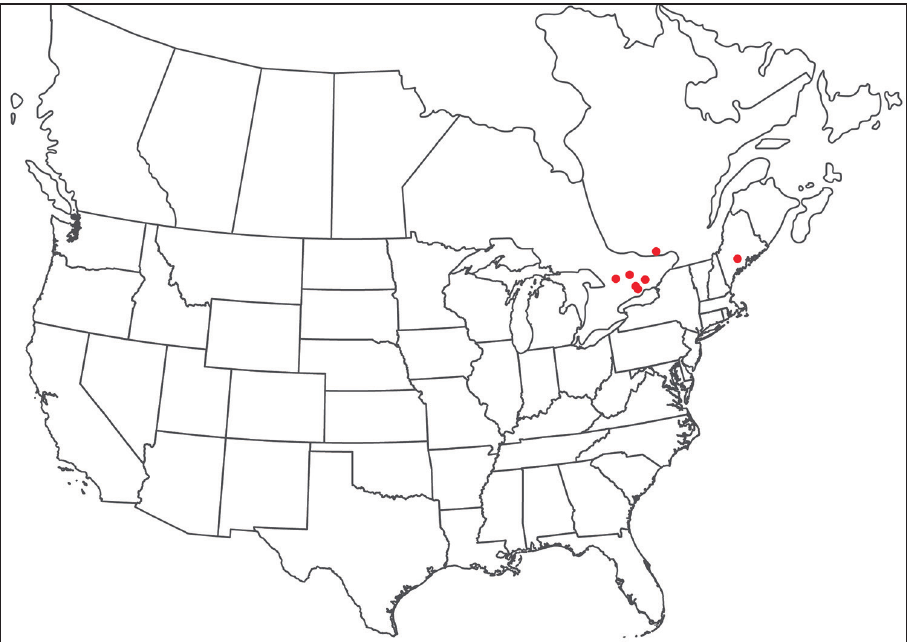
Figure 149. Torrenticola mjolniri sp. n.